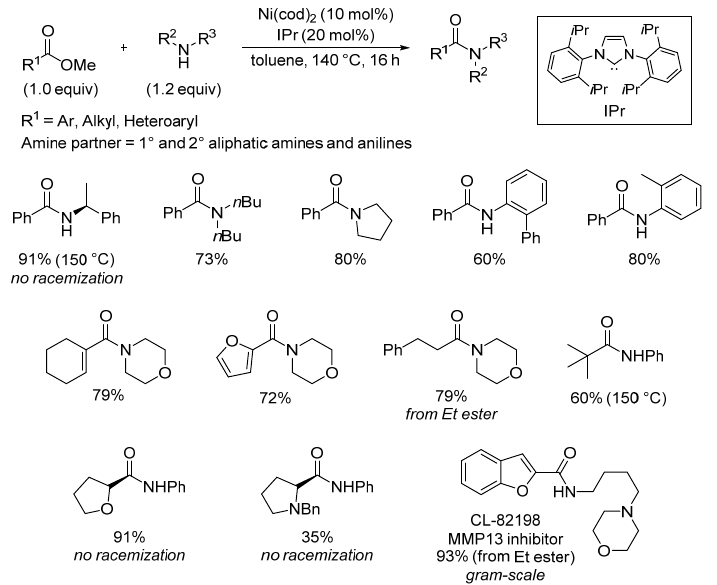
propylphenyl)imidazole ‐ 2 ‐ ylidene (IPr) (20 mol%) as ligands in toluene at 140 °C for 16 h.